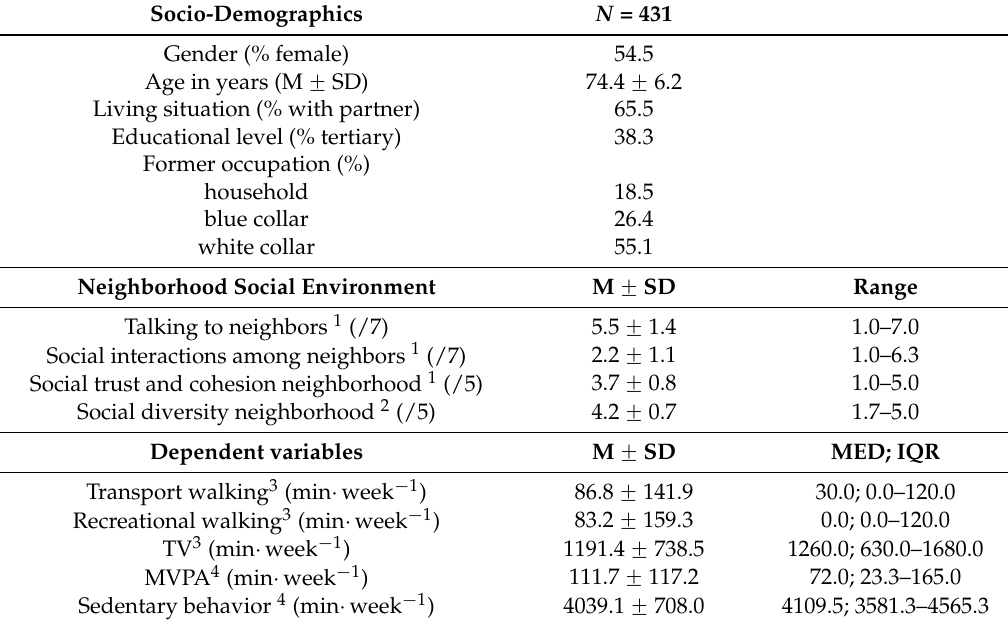
Table 1. Socio-demographics, neighborhood social environment and older adults’ PA and SB